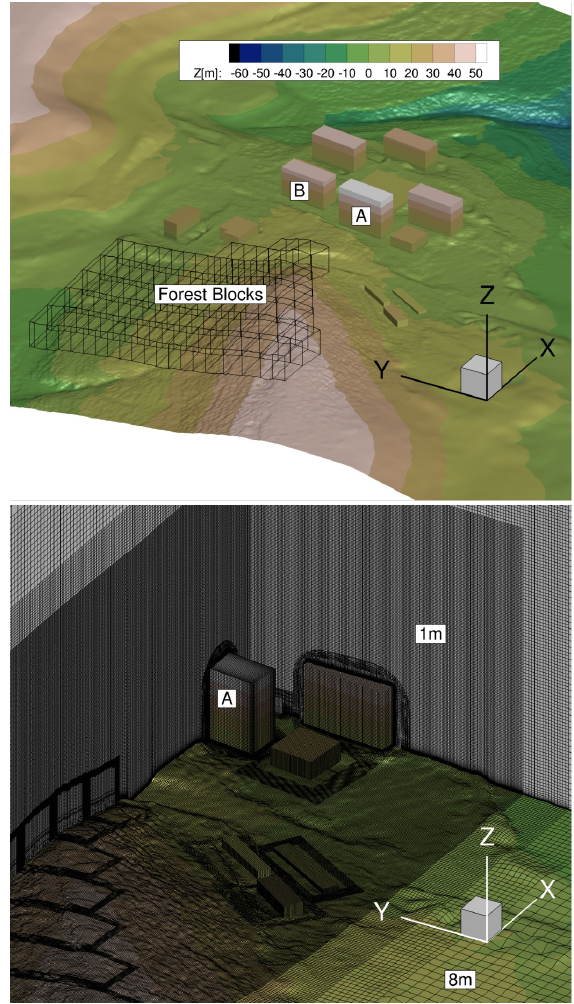
Figure 2. The urban-terrain model and computational grid.